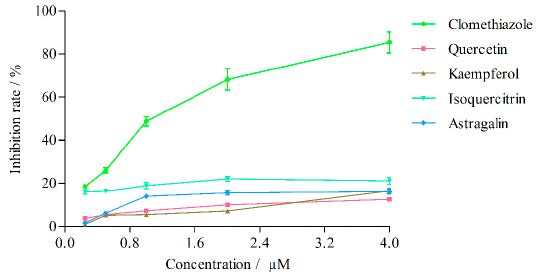
Figure 4. Effects of flavonoids on CYP2E1 isozyme activities.